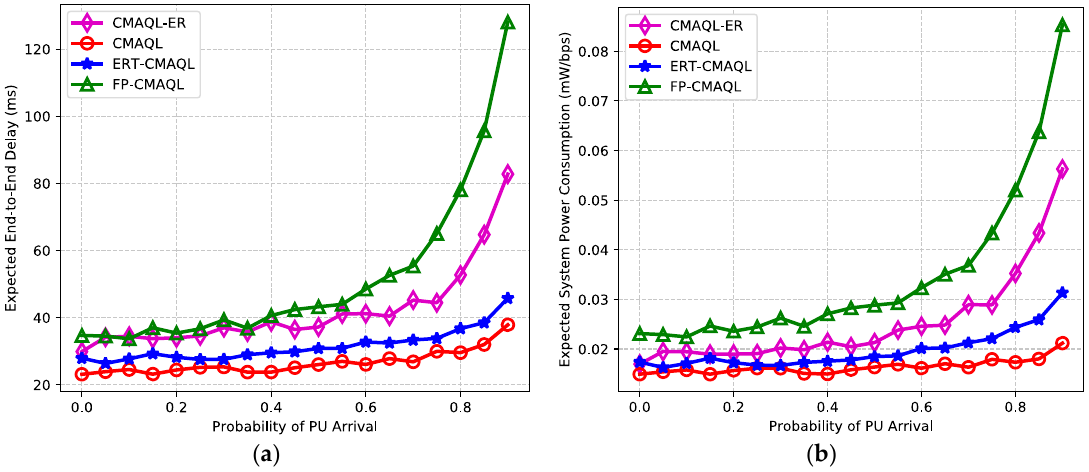
Figure 6. ( a ) Expected end-to-end delay and ( b ) expected system power consumption.